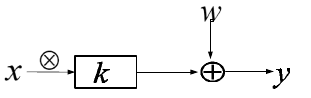
Figure 1. Image blurring degeneration model.